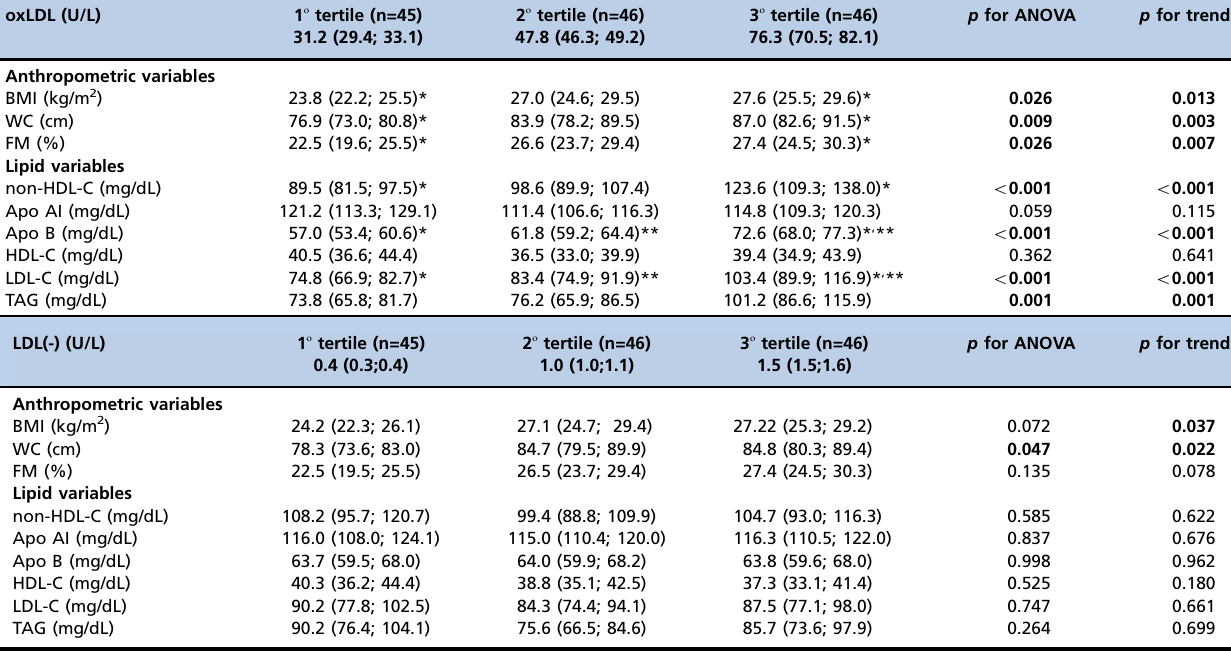
Table 2 - Analysis of variance (ANOVA) and linear trend between oxLDL and LDL(-) and anthropometric and lipids parameters. oxLDL (U/L) 1 o tertile (n=45)